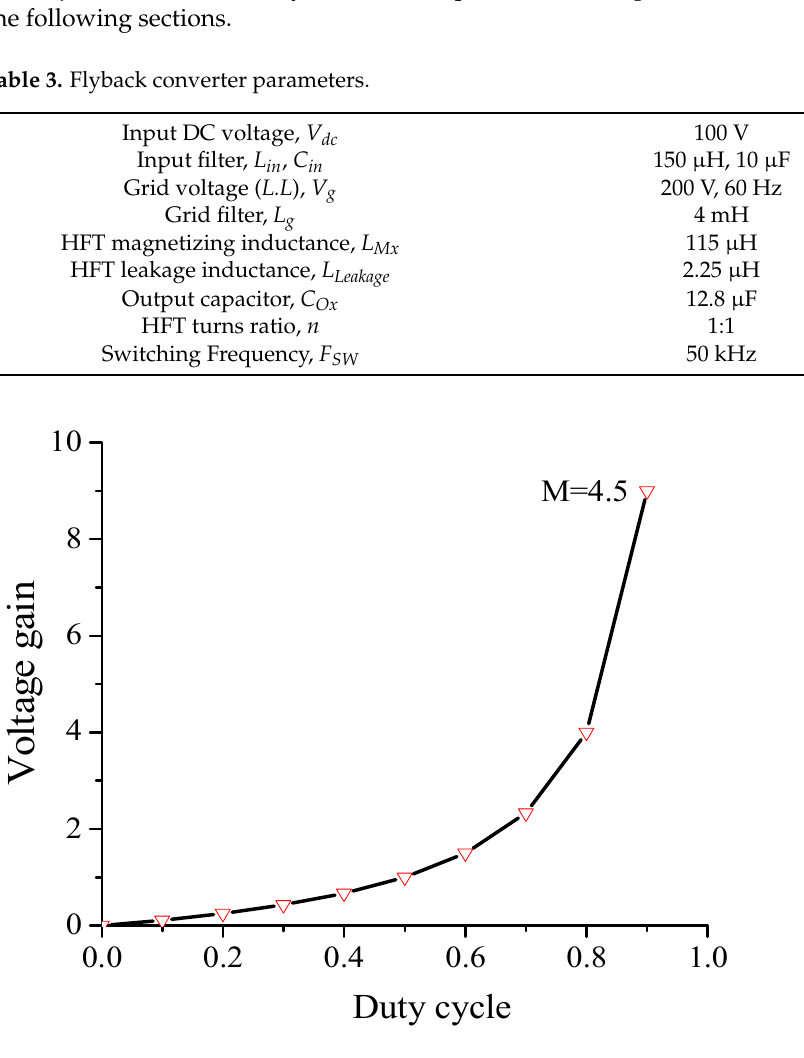
Figure 7. Flyback converter voltage gain.